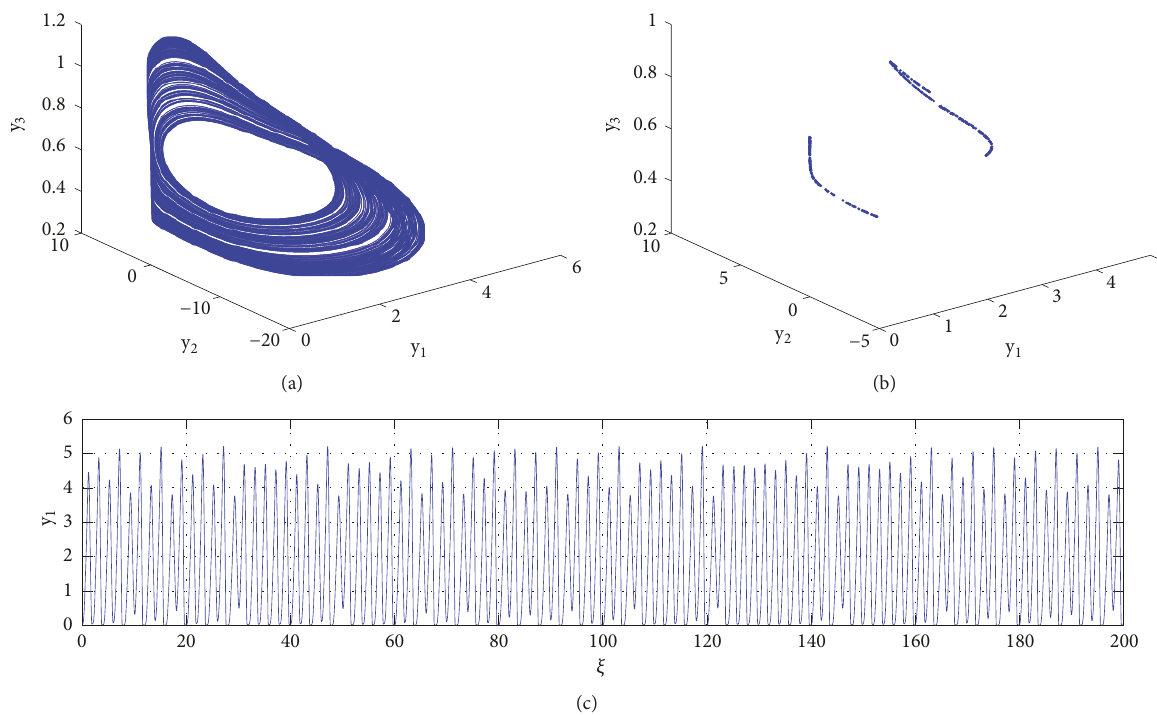
Figure 10: Chaos through period doublings when 𝑘 0 = 20, 𝜀 = 0.69 : (a) phase orbit, (b) Poincar´e section, and (c) time series.